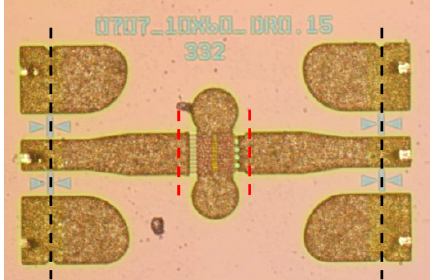
Figure 1. Picture of the HEMT with a gate width of 10 × 60 µ m.